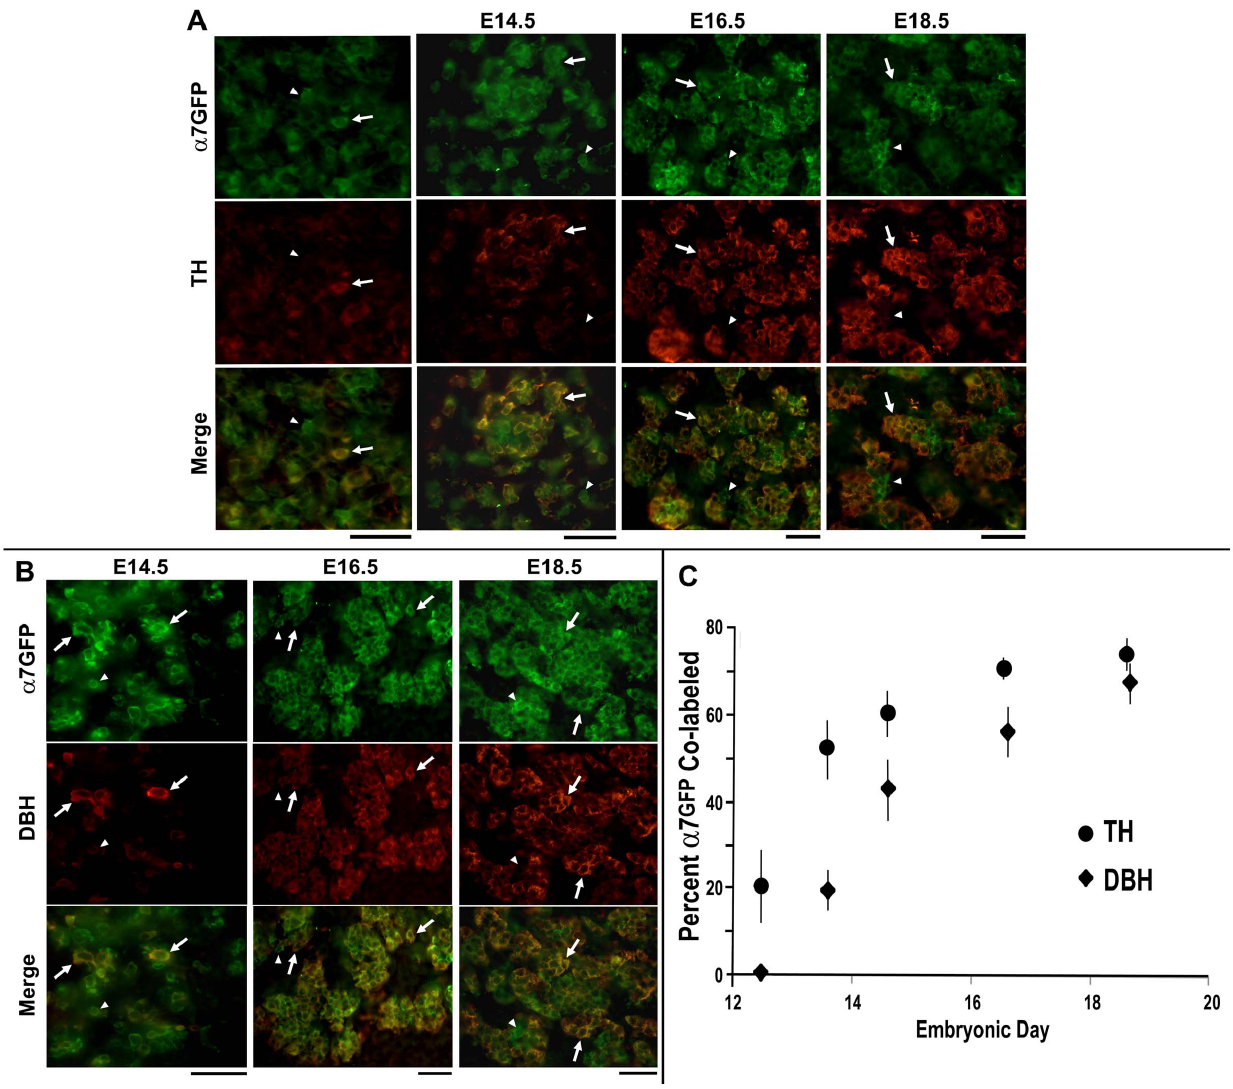
Figure 3. Coincident appearance of a 7 G and catecholamine markers during chromaffin cell development. The adrenal glands from a 7 G mice at the E12.5, E14.5, E16.5 and E18.5 developmental stages were co-stained for immunoreactivity to GFP (green) and in red either (A) tyrosine hydroxylase (TH) or (B) dopamine-beta-hydroxylase (DBH). C . Quantification of the a 7 G cells co-labeled with either TH or DBH for the developmental stages. For each point at least 3–5 sections from the adrenal glands were collected from 3–6 different animals and the results from each individual animal were then summarized. The error bars reflect + / 2 standard error of the mean. Scale bar =25 m m (E12.5, E14.5) or 50 m m (E16.5, E18.5).